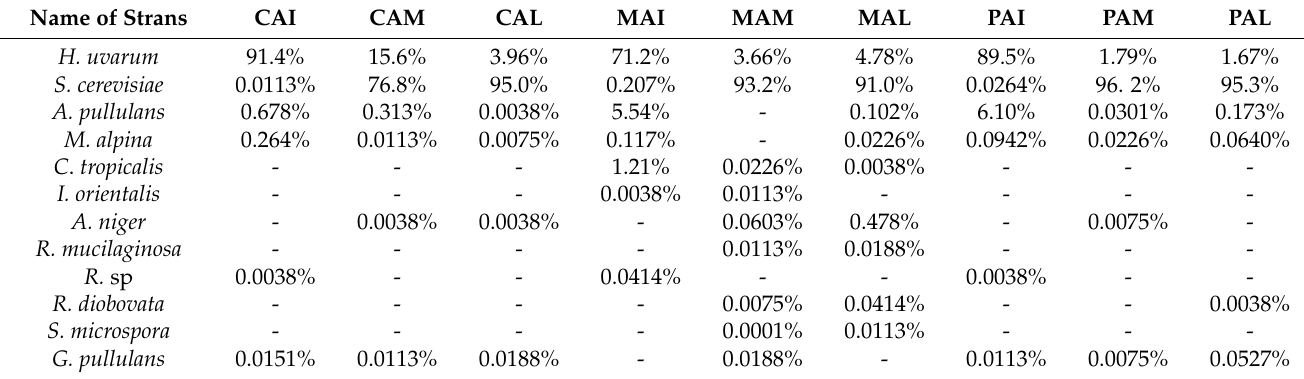
Table 3. Proportion distribution of representative strains in different